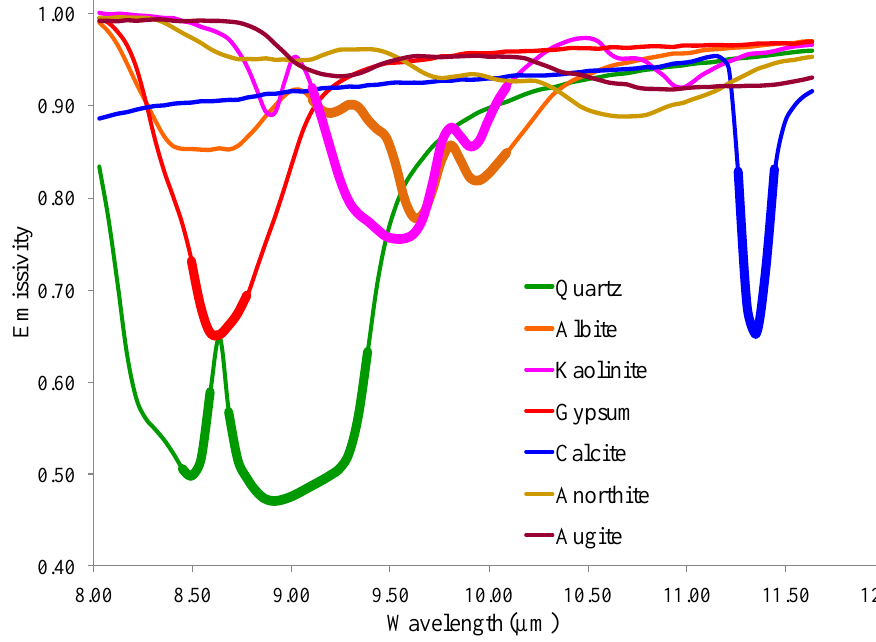
Figure 5. Emissivity spectra of minerals based on [14] and resampled to the AisaOWL spectral configuration. The minerals in the figure are mentioned in the text. Thick lines represent the main mineralogical